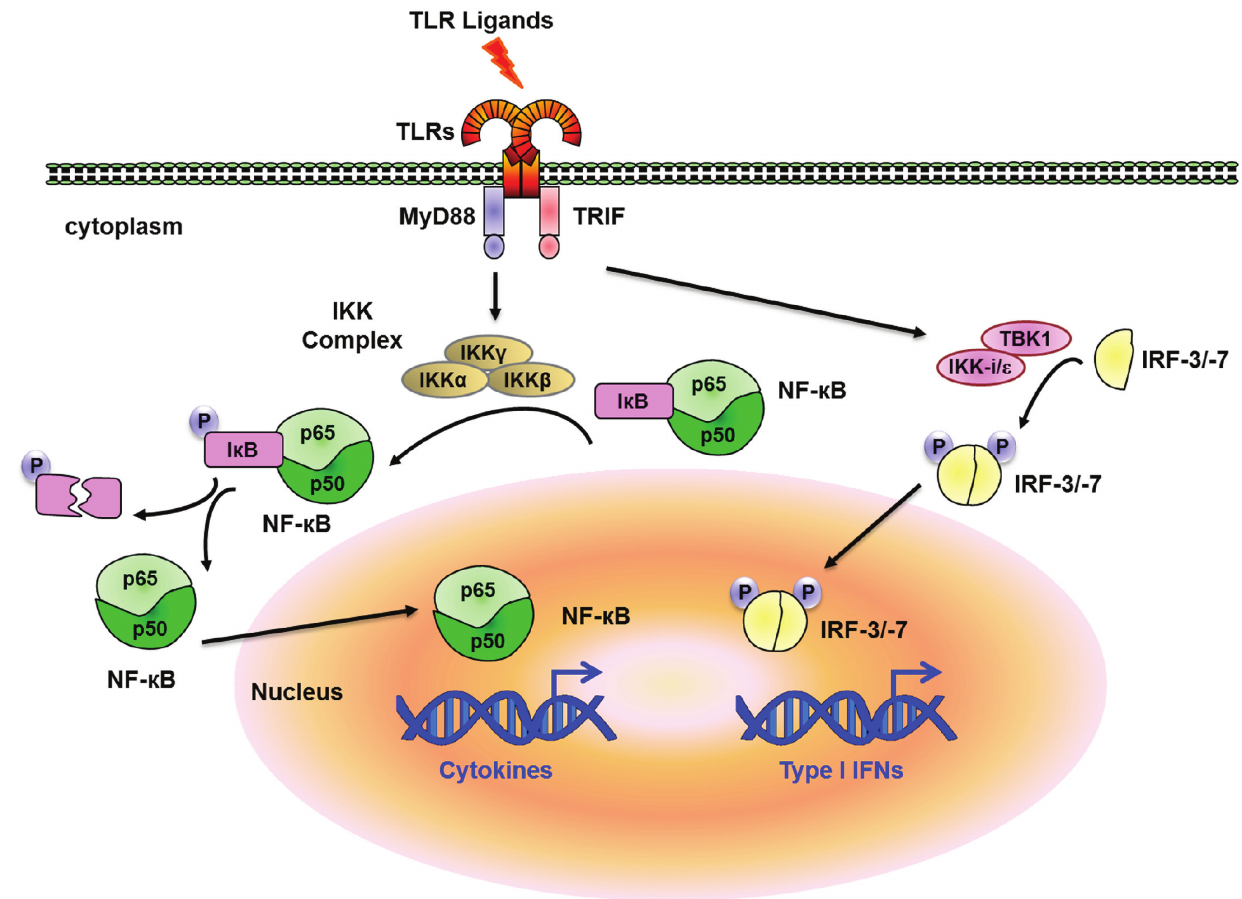
Figure 1. TLR Signaling and NF-(cid:2)B activation. Stimulation of TLRs trigger the association of The Toll/interleukin-1 (IL-1)-receptor (TIR)-domain-containing adaptor molecule MyD88 which mediates the TLR-signaling pathway leading to the activation of the IKK complex, which consists of IKK-(cid:5), IKK-(cid:3) and IKK-(cid:6) (also known as IKK1, IKK2 and nuclear factor-(cid:2)B (NF-(cid:2)B) essential modulator, NEMO, respectively). This pathway is used by TLR1, TLR2, TLR4, TLR5, TLR6, TLR7 and TLR9 and degradation of the phosphorylated I(cid:2)B by the ubiquitin proteasome system allows the translocation of NF-(cid:2)B to the nucleus where it activates the expression of cytokine genes ( Il6 , Tnf , etc. ). Another TIR-domain-containing adaptor, TRIF, is essential for the MyD88-independent pathway. The non-typical IKKs IKK-(cid:4) and TBK1 mediate phosphorylation of IRF3/7 downstream of TRIF. This phosphorylated IRF3/7 translocates into the nucleus to induce expression of type I IFN and IFN inducible genes ( Ifnb , Cxcl10 , etc